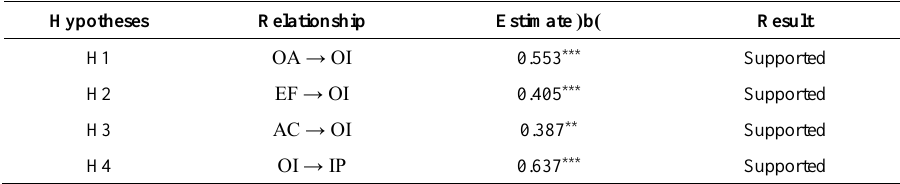
Table 5. Structural parameter estimates.